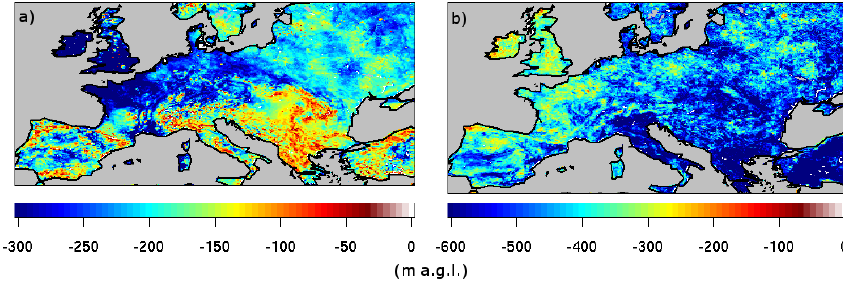
Fig. 8. Time averaged MH differences for all land grid cells < z i, myj − z i, ysu > in meters above ground level at 01:00UTC (a) and 12:00UTC (b) .